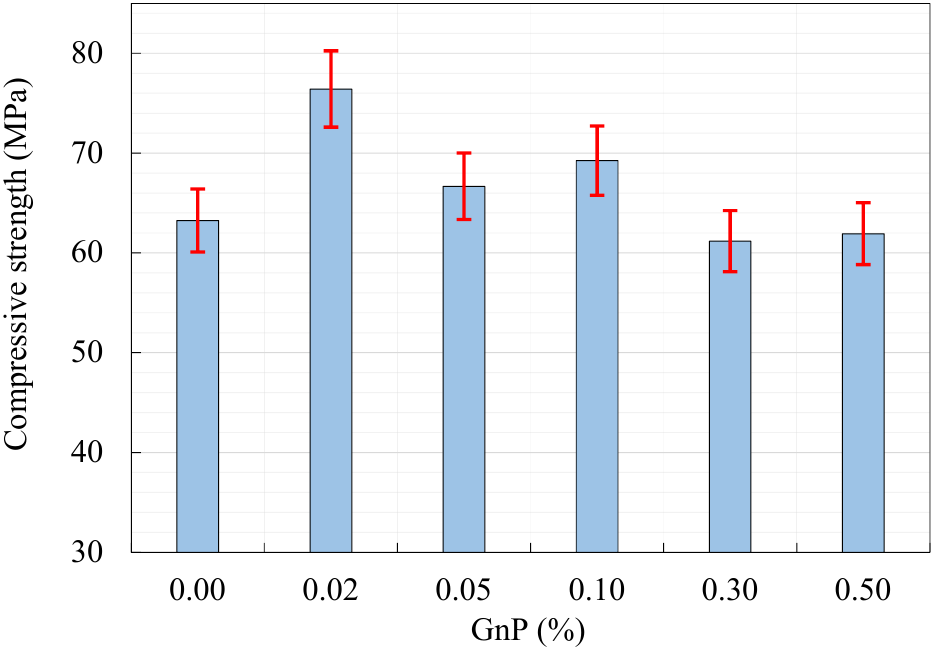
Figure 7. Compressive strength of HPC-GnP mixes.